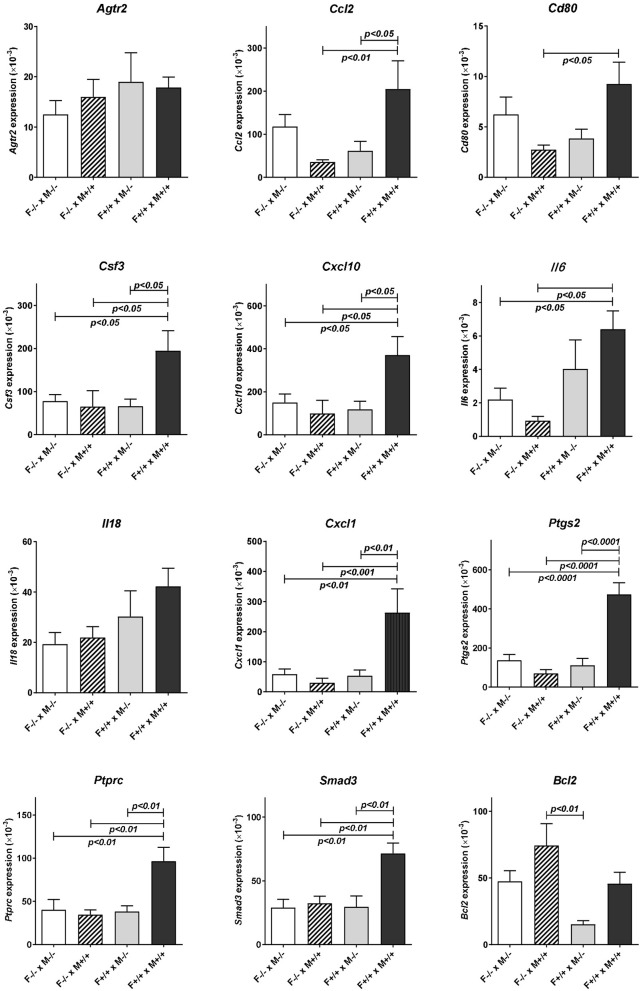
Real-time qRT-PCR quantification of specific transcript levels in RNA extracted from the individual uteri of different mating combinations utilizing Rln+/+ and Rln−/− male and female mice, as indicated. Data are mean ± SEM. p-values indicating effect of treatment group on cytokine mRNA concentration are shown.